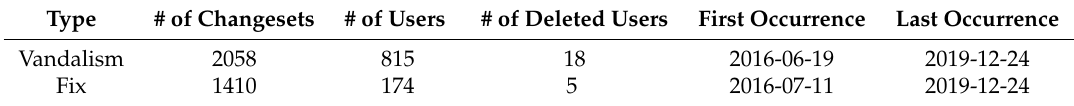
Table 1. Summary statistics of vandalism and fix